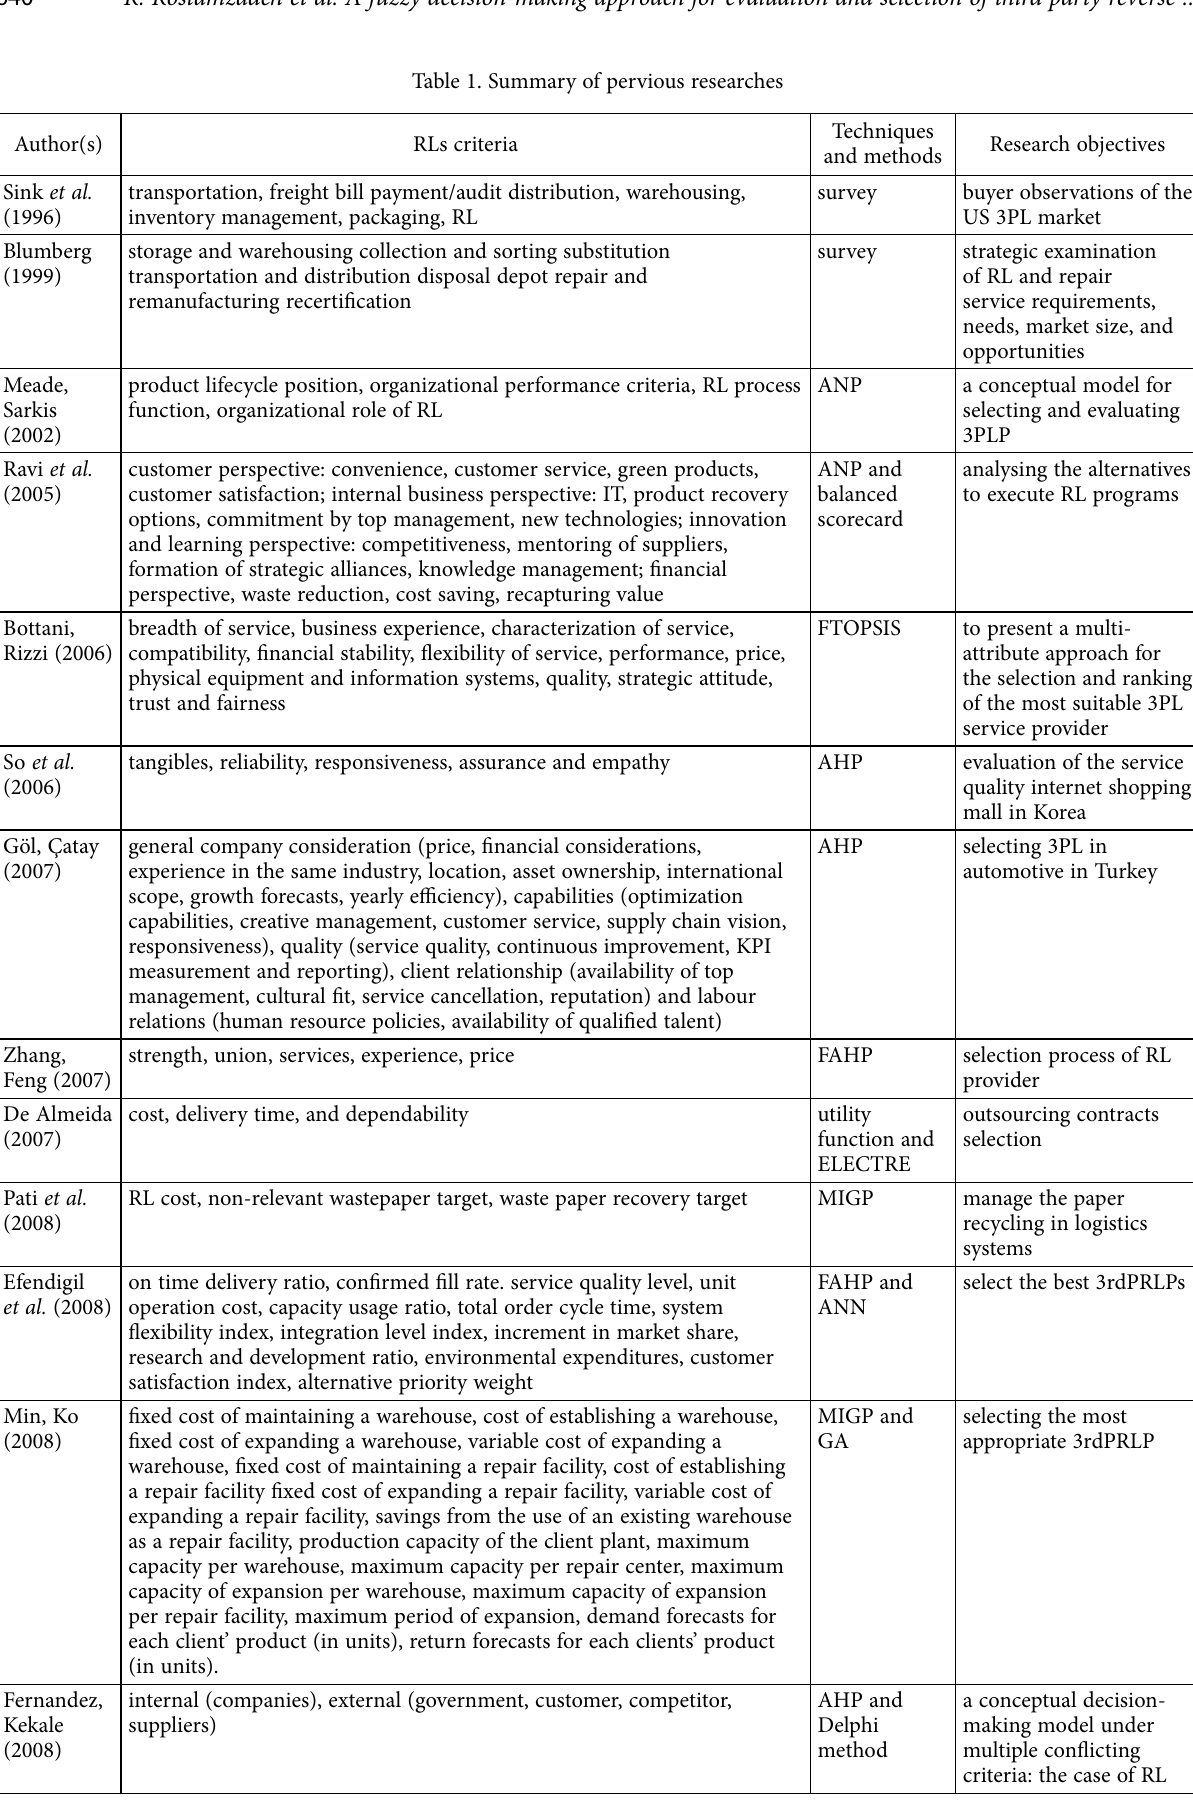
Table 1. Summary of pervious researches